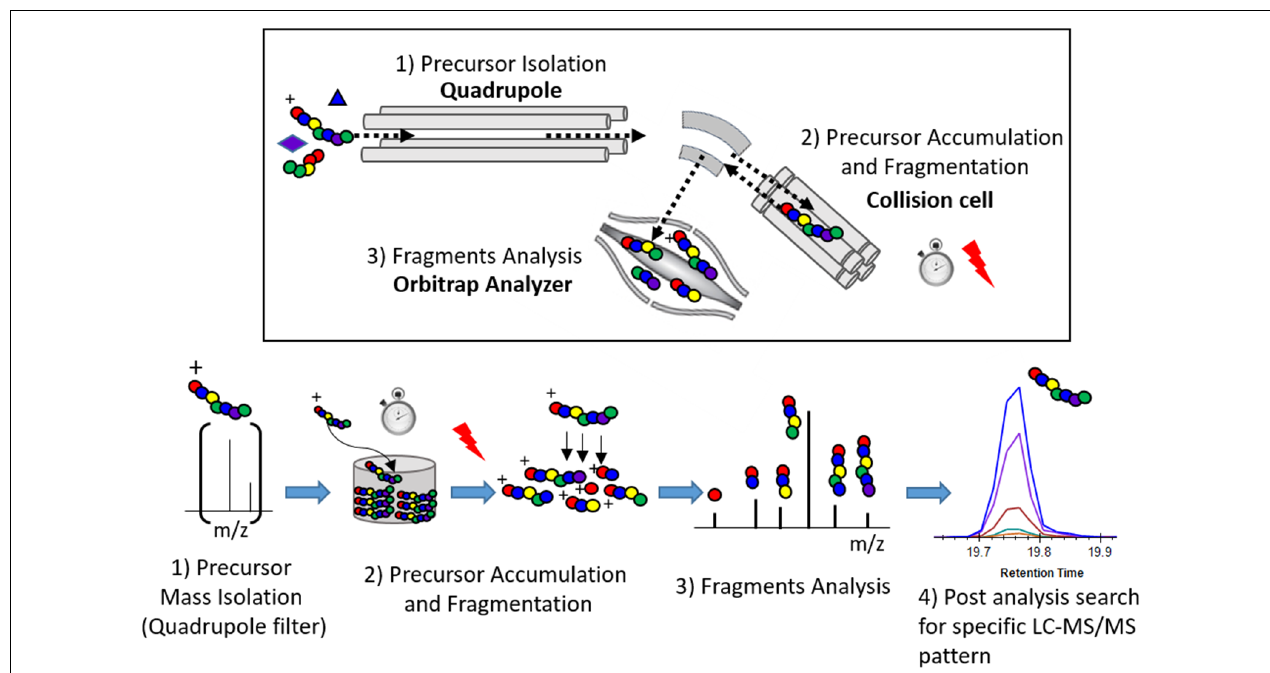
FIGURE 1 | Principle of the parallel reaction monitoring (PRM)